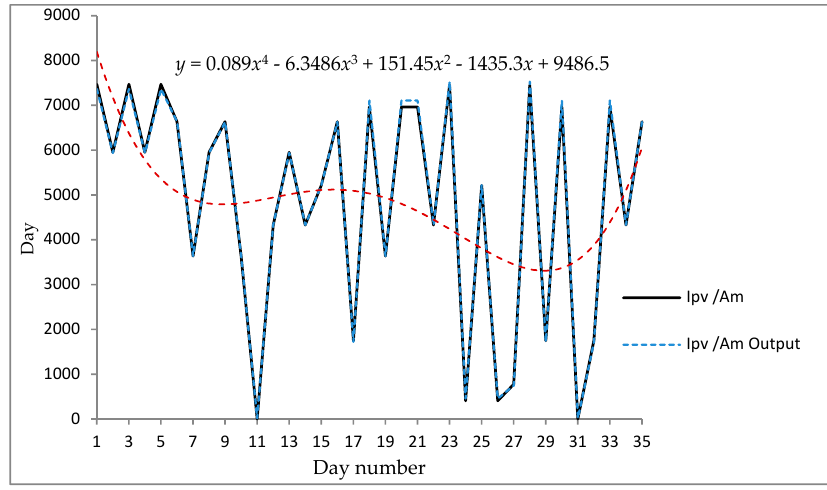
Figure 13. Testing the results of the desired data and the forecasting SOFM model using 5000 epochs.